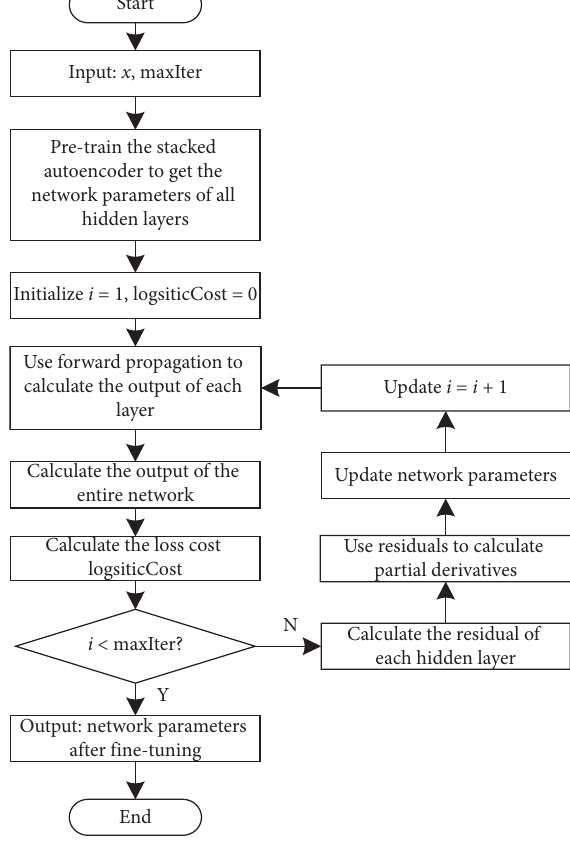
Figure 4: Algorithm flow of training